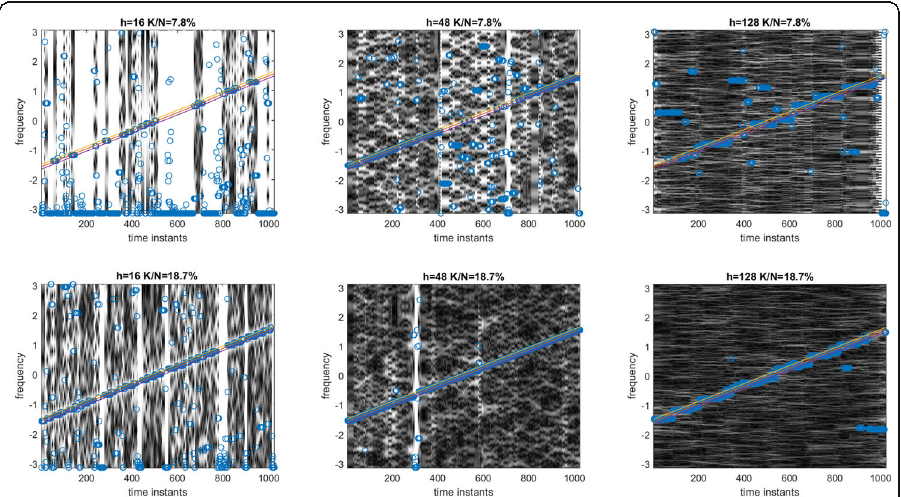
Fig. 2 STFTs with various numbers of available samples ( K / N =7.8% — upper row and K / N =18.7% — lower row) and for three different window widths (left column h =16, middle column h =48, and right column h =128). Middle line corresponds to the exact IF, two parallel lines are separated Δω from the exact IF (zone of correct estimates (8)) and circles are the IF estimates. The white area on graphs corresponds to missing values of the STFTs due to narrow windows and a small number of available